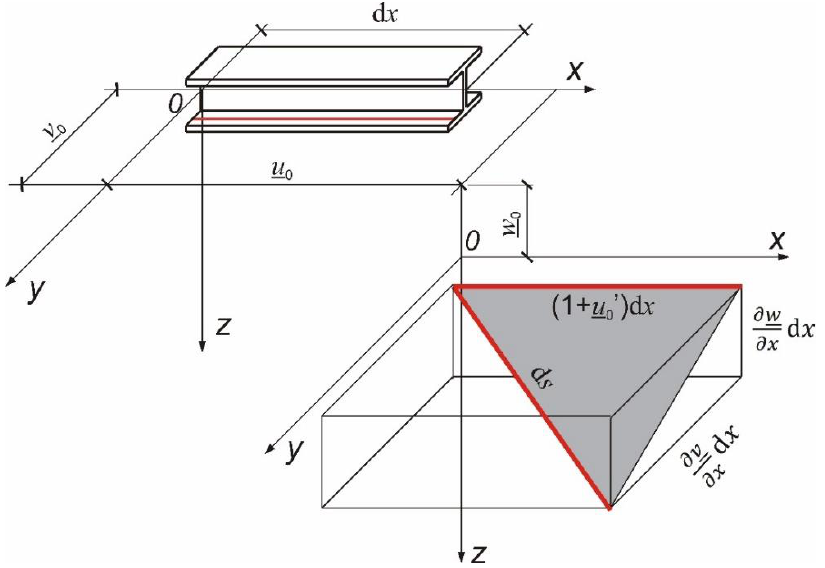
Figure 2. Fiber kinematics.